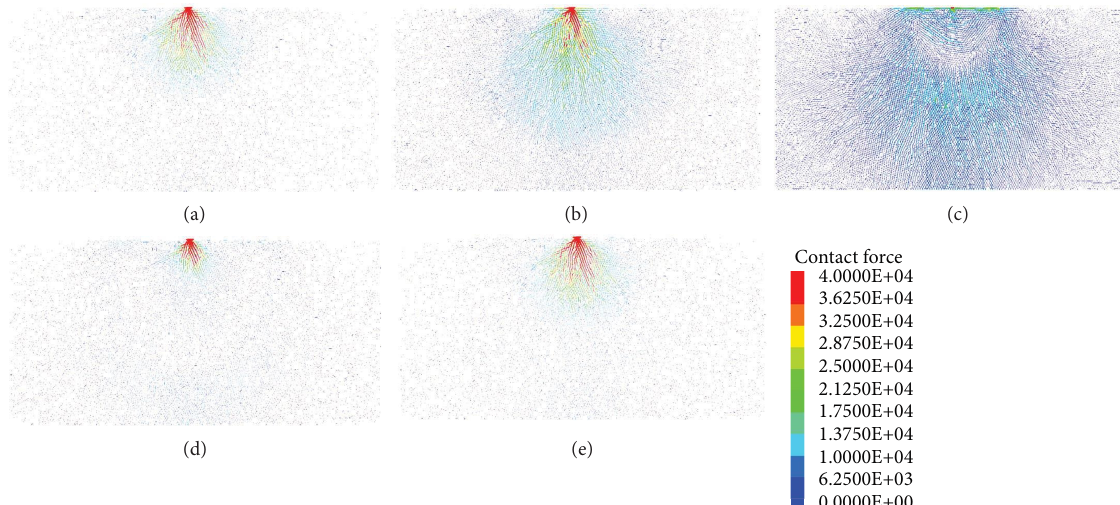
Figure 7: Distribution of contact force (a)–(e) change of contact force in one